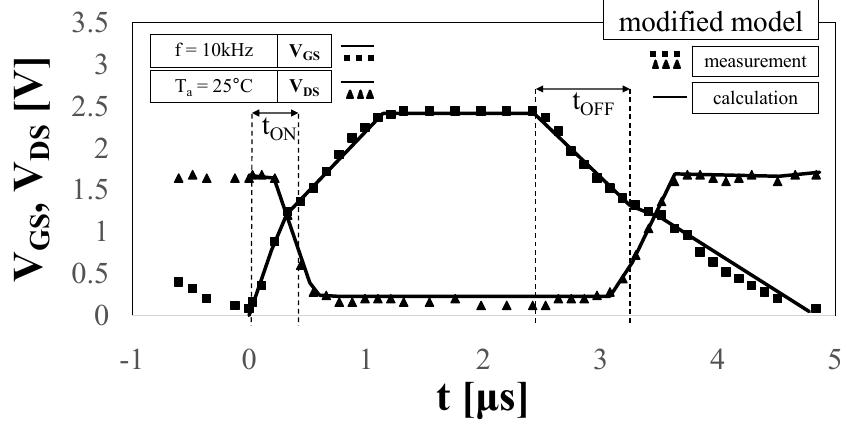
Figure 10. Calculated and measured time waveforms of the gate–source and drain–source voltage of the JFET in the switching circuit.